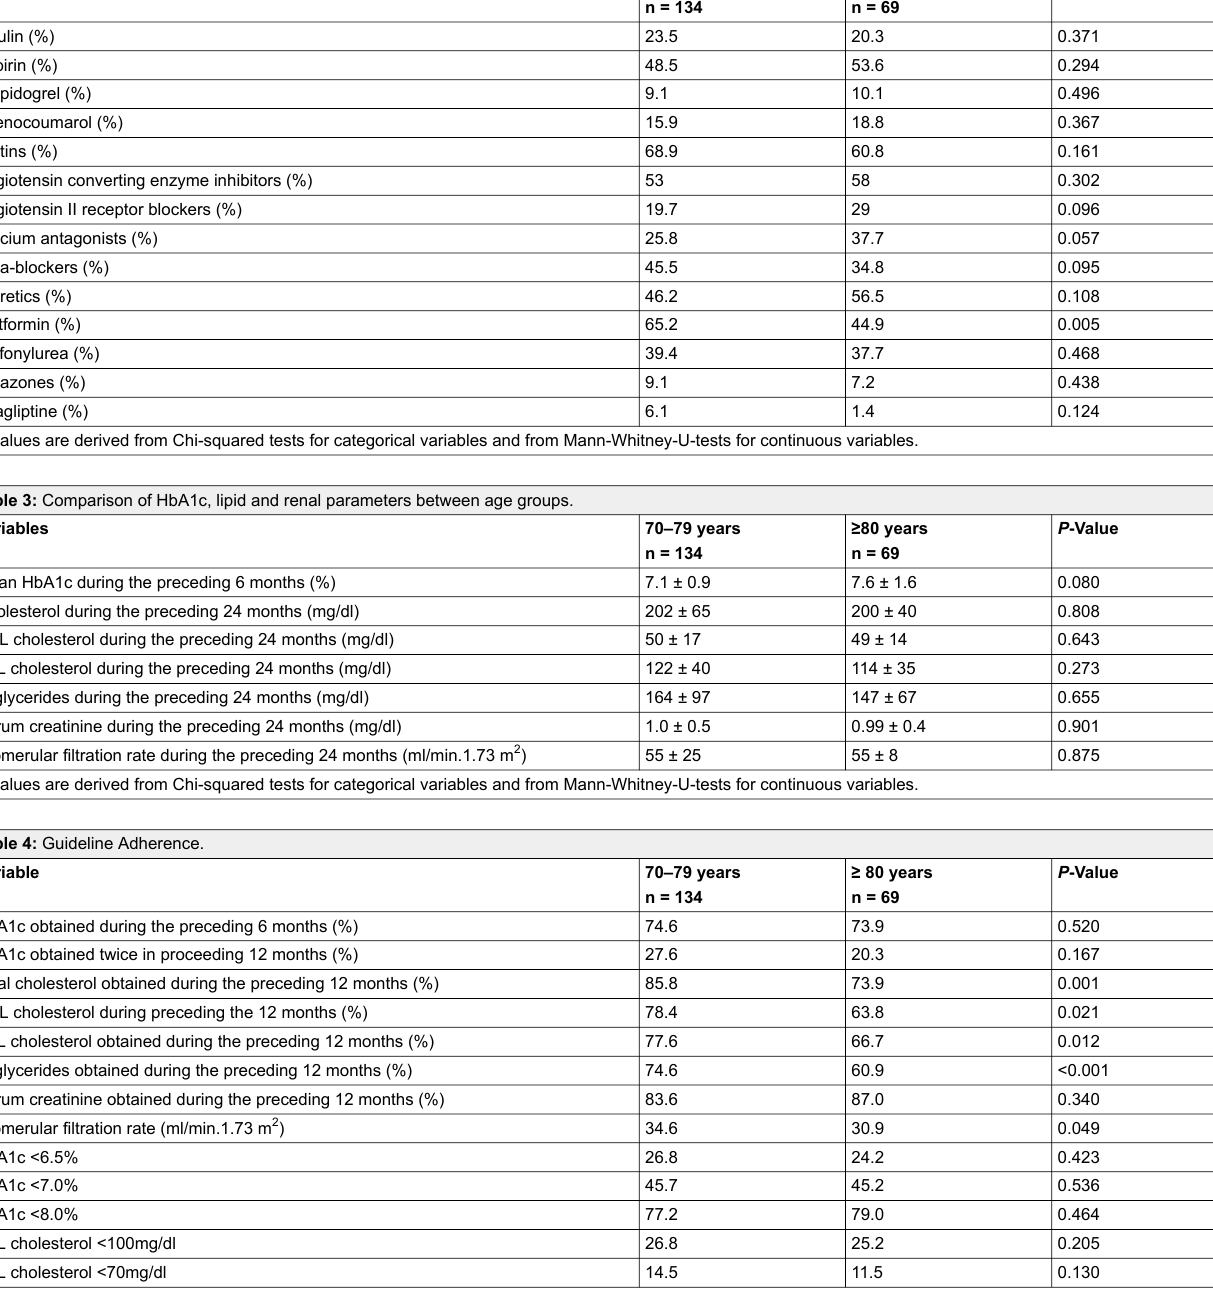
Table 2: Comparison of diabetes-related and of major cardiovascular medications between age groups. Variables